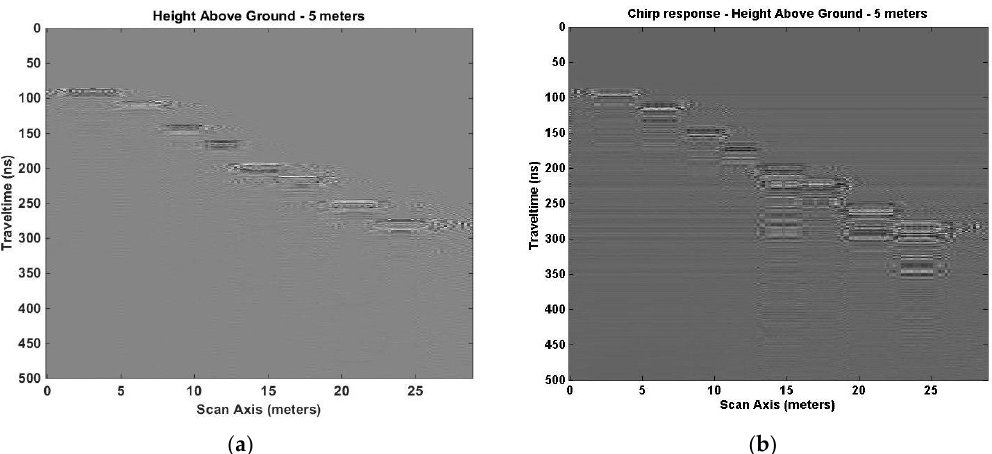
Figure 19. Defined space of SA3, (8) 2-m-long plates, 0.1 m thick with Tx/Rx pair 5 m above ground [5].